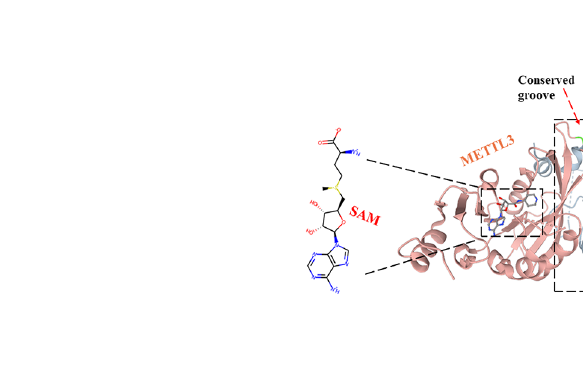
FIGURE 2 | Structure of the METTL3-METLL14